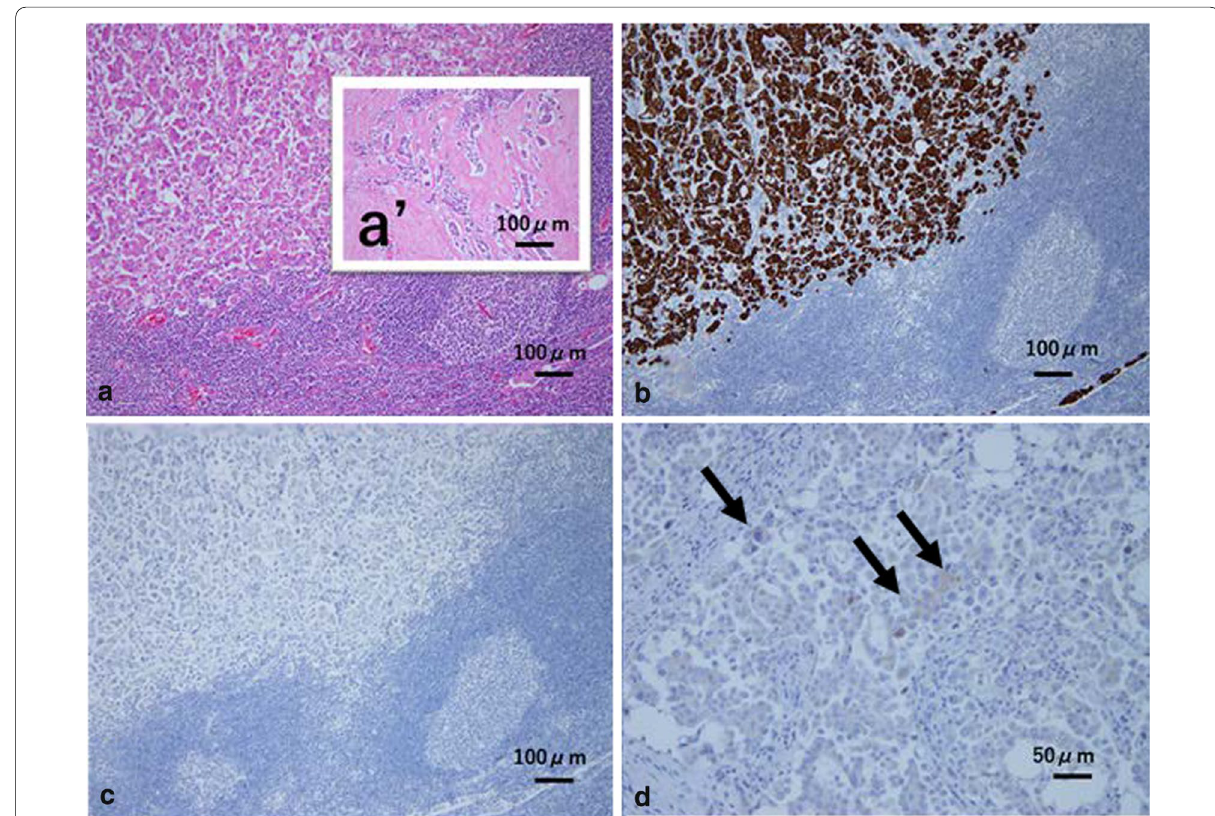
Fig. 4 a Cancer cells forming micropapillary or compact nested foci were found to invade into the lymph node, which is compatible with primary breast cancer (hematoxylin and eosin (HE) 100). a’ Primary breast cancer showed predominant in scirrhous type. (HE × CK 7-positive ( 100). c Cancer cells were CK 20-negative ( 100). d Mammaglobin-positive cells (arrows) ( × ×